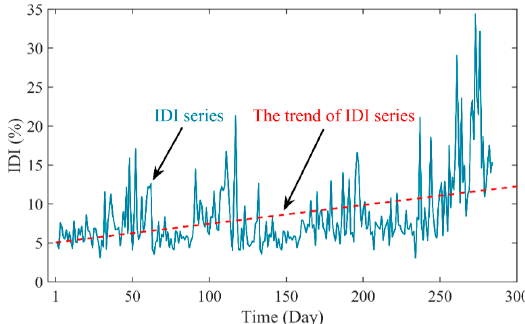
Figure 8. The IDI series of the performance degradation tendency.